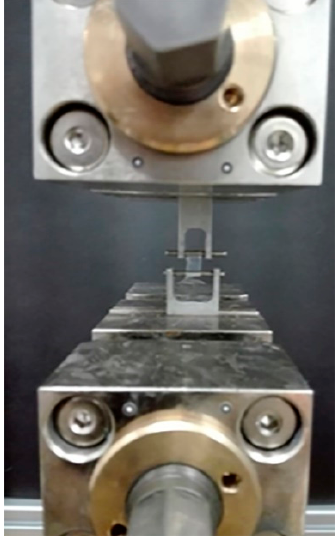
Figure 2. Tensile test tubular hydrogel material on the machine.